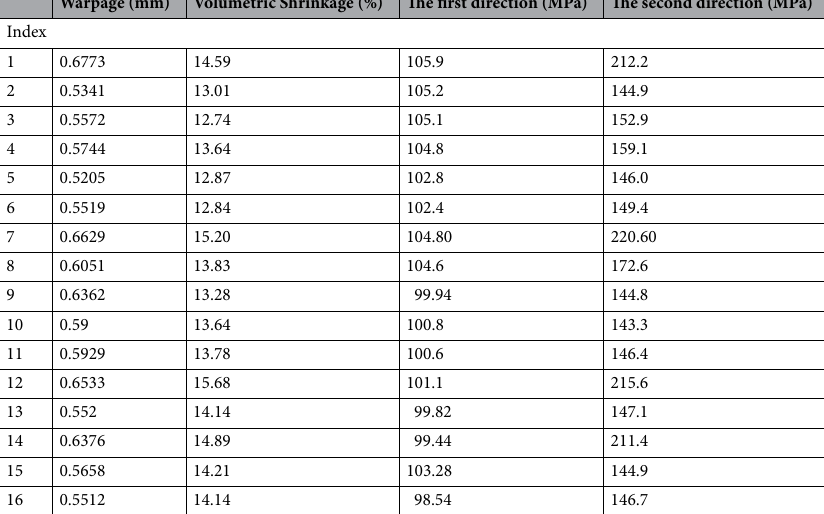
Table 3. Experimental results of orthogonal design.